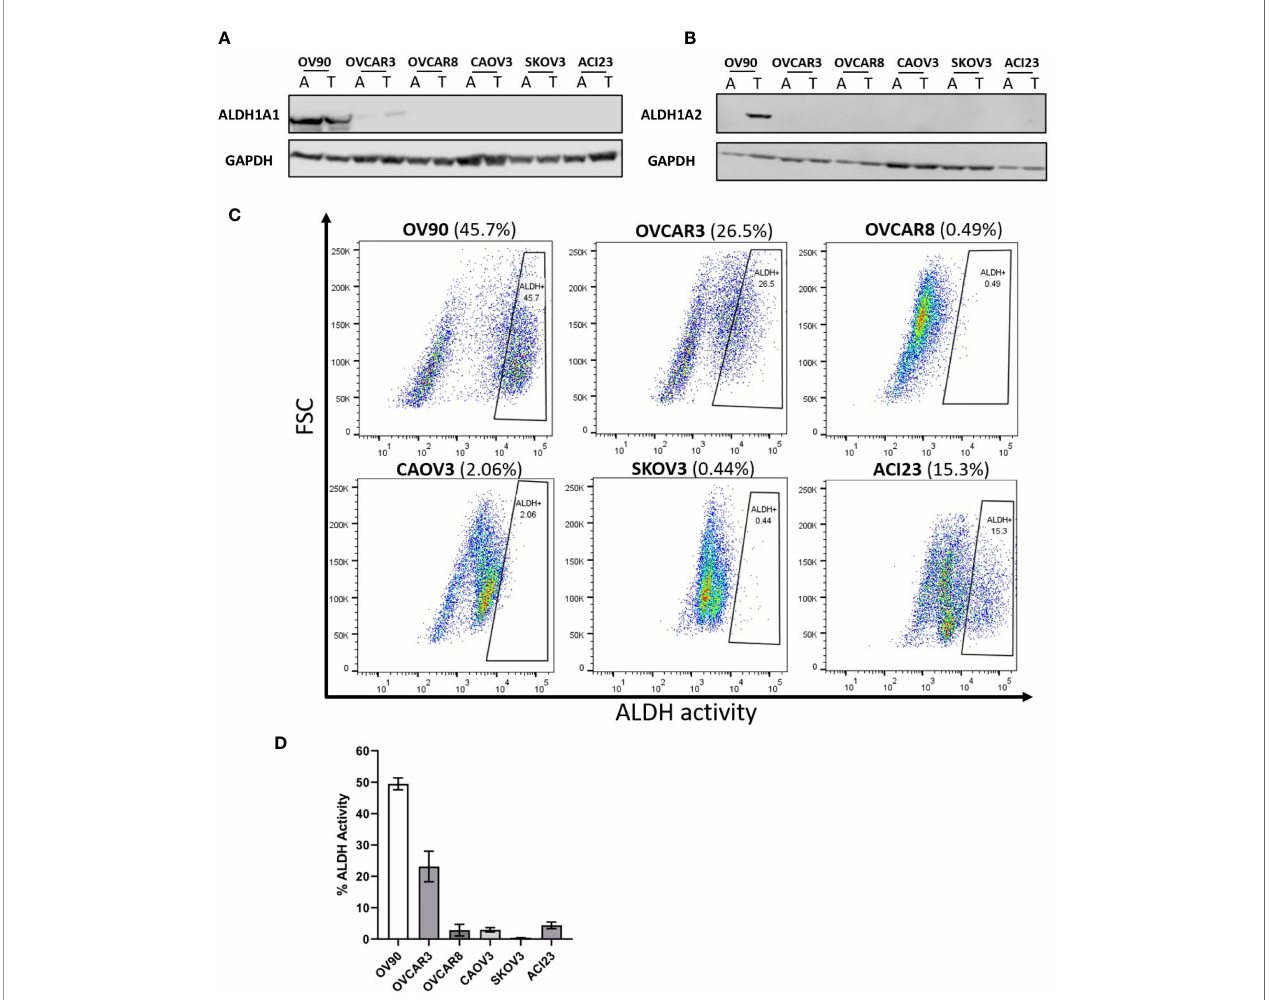
FIGURE 1 | Detection of ALDH1 isoforms in ovarian cancer cell lines by Western blot analysis, and measurement of ALDH activity in TICs determined by ALDEFLUOR fl ow cytometry assay. Western blot analysis of lysates probed for the expression of (A) ALDH1A1 and (B) ALDH1A2 in the indicated cell lines in adherent and TIC growth conditions. (C) The ALDH-positive population of TICs in the indicated cells lines detected via fl ow cytometry after 72 h in TIC growth conditions. (D) Quanti fi ed percentages of ALDH activity in cell lines (n = 2). Graphs represent mean and SEM of each indicated cell line. A, adherent cells; T,